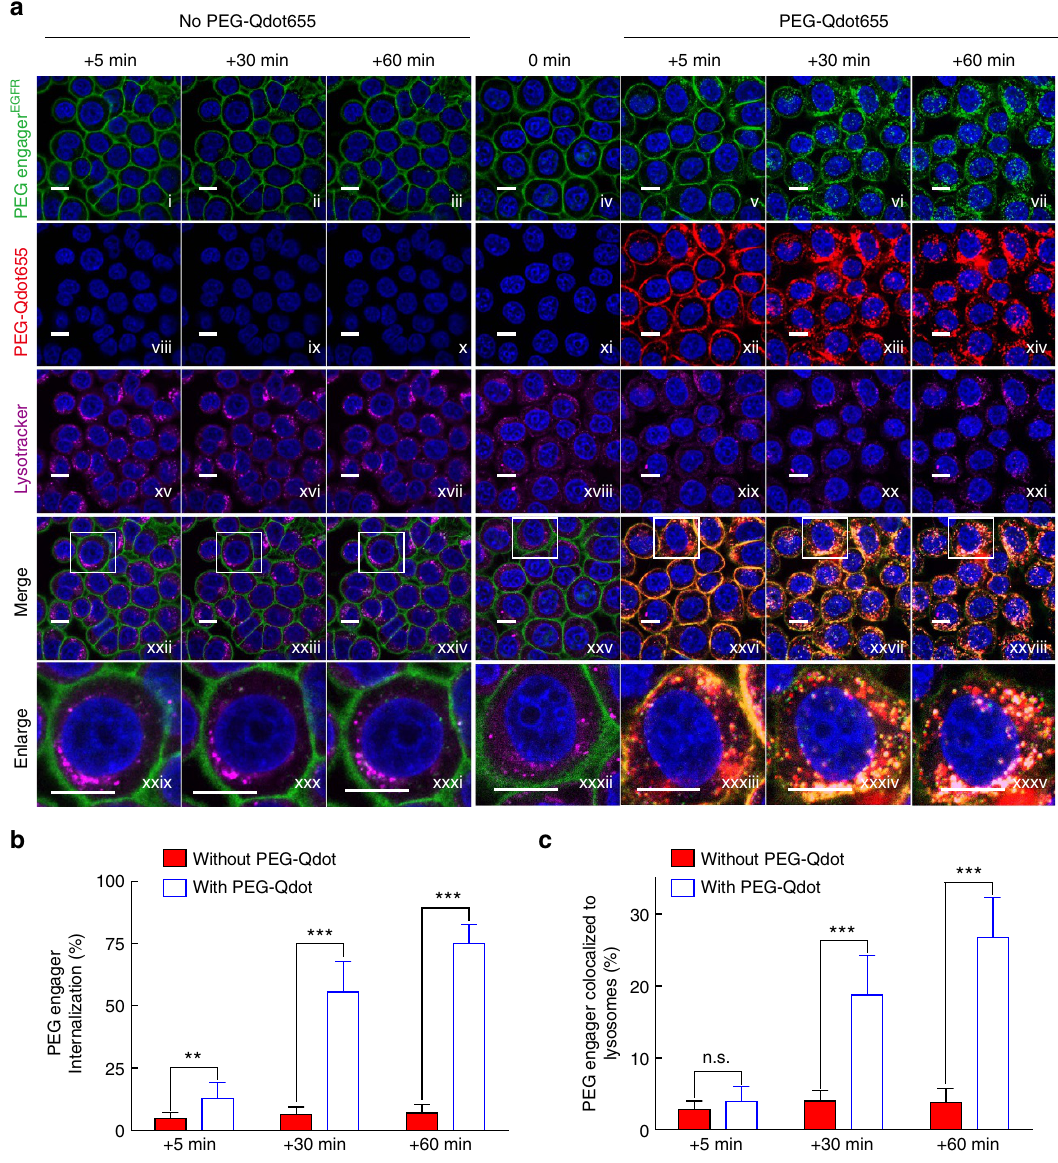
Figure 4 | PEG engager EGFR conditional internalization. ( a ) Fluorescent-labelled PEG engager EGFR on the cell membrane of MDA-MB-468 cells after 1h at 37 (cid:2) C (green, iv) was real-time imaged 5, 30 and 60min after incubating without (i–iii) or with (v–vii) PEG-Qdot655. Hoechst 33342 (blue), PEG-Qdot655 (red, xiii–xiv) and LysoTracker Red DND-99 (purple pseudo colour, xv–xxi) are also shown for nucleus, Qdots and lysosome staining, respectively. Merged (xxii–xxviii) and enlarged (xxix–xxxv) images are also shown. Scale bar, 10 m m. ( b ) Percentage of the PEG engager EGFR that internalized into cells complexed with (white bars) or without (red bars) PEG-Qdot655 at different times was quantified from confocal images of individual cells ( n ¼ 15). ( c ) Percentage of PEG engager EGFR that co-localized with LysoTracker Red DND-99 (lysosomes) at different times was quantified from confocal images of individual cells ( n ¼ 15). Representative confocal images from two independent experiments are shown. Data are shown as mean ± s.d. Significant differences in percentage of PEG engager EGFR internalization or lysosome co-localization with and without addition of PEG-Qdot655 are indicated: ** P r 0.001, *** P r 0.0001 (two-way analysis of variance). NS, not